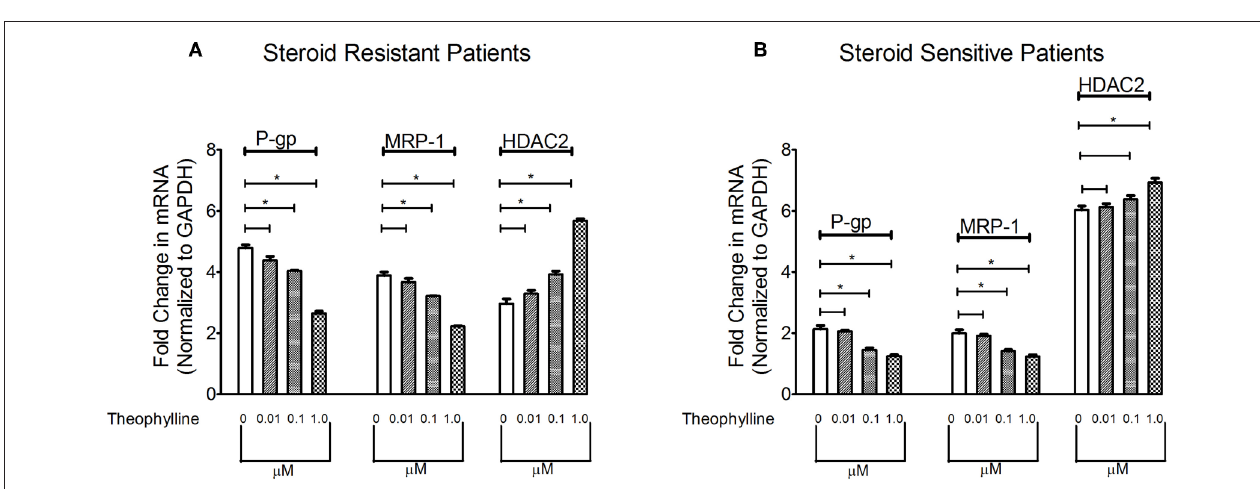
FIGURE 2 | Effect of HDAC2 stimulator Theophylline on expression levels of P-gp, MRP-1 and HDAC2 in SRNS and SSNS patients (A,B). Quantitative real-time PCR of P-gp, MRP-1 (A) and HDAC2 (B) in peripheral blood mononuclear cells of SRNS and SSNS patients treated with different concentrations of Theophylline (0, 0.01, 0.1, 1.0 µ M) for 48h. The experiments are representative of three independent series. Pooled data of all the experiments are represented as mean ± SEM. Significant differences compared to control are indicated by * p <